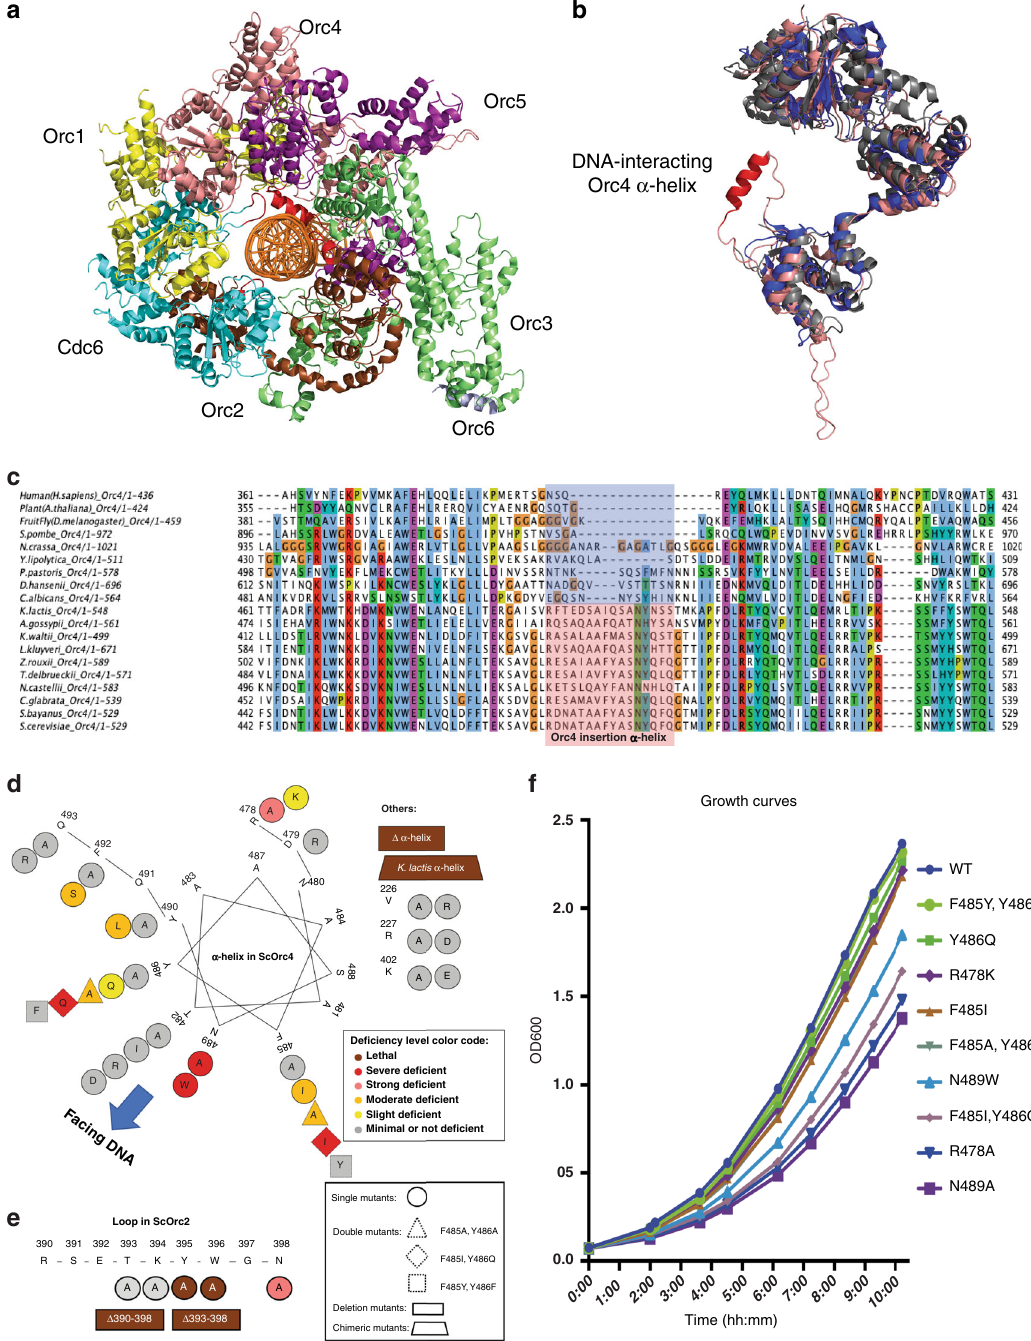
Fig. 1 DNA interacting Orc4 α -helix and Orc2 loop are essential. a Top-view of ORC – Cdc6 structure encircling an origin DNA with Orc1 – 6 and Cdc6 indicated. Recolored from previous cryo-EM work 6 OCCM structure (PDB code 5udb) and Orc4 α -helix and Orc2 loop that interact with DNA are colored in red. b Orc4 structure superposition of human Orc4 in blue (from PDB code 5uj7), Drosophila Orc4 in gray (from PDB code 4xgc) and S. cerevisiae Orc4 in salmon (from PDB code 5udb). Orc4 α -helix that interacts with DNA is colored in red. c Multiple sequence alignment of Orc4 among representing eukaryotic species as indicated. Orc4 α -helix region indicated with species that do not have sequence-speci fi c origins shadowed in blue and species that sequence-speci fi c origins exist shadowed in pink. d , e Maps of mutant viability phenotypes from the plasmid shuf fl e assay: Orc4 α -helix in a helical wheel d and Orc2 loop in connected line e . Mutant de fi ciency phenotypes (Supplementary Figs. 2 and 3) are summarized in color codes as indicated. Amino acids indicated in one-letter abbreviation. Different mutant types are indicated with different shapes. f Growth curves of NTAP-Orc4 integrated strains (see “ Methods ” section) in YPD with initiation OD600 at 0.05 at 30 °C to measure OD600 at different time